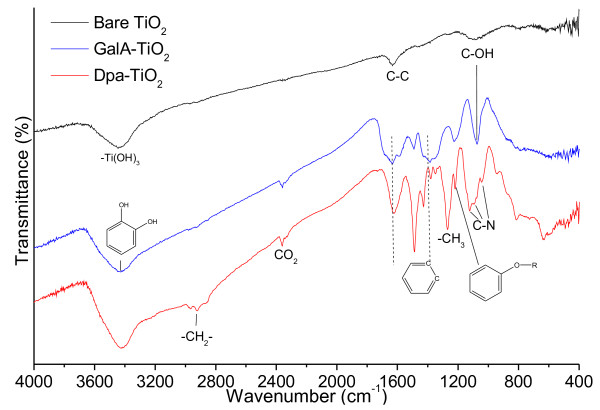
FT-IR spectra of dried bare Dpa- and GalA-TiO
2
NPs.